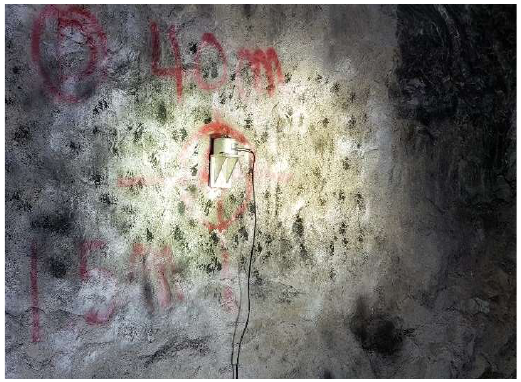
Figure 4. Speckle pattern in the region of interest (ROI).